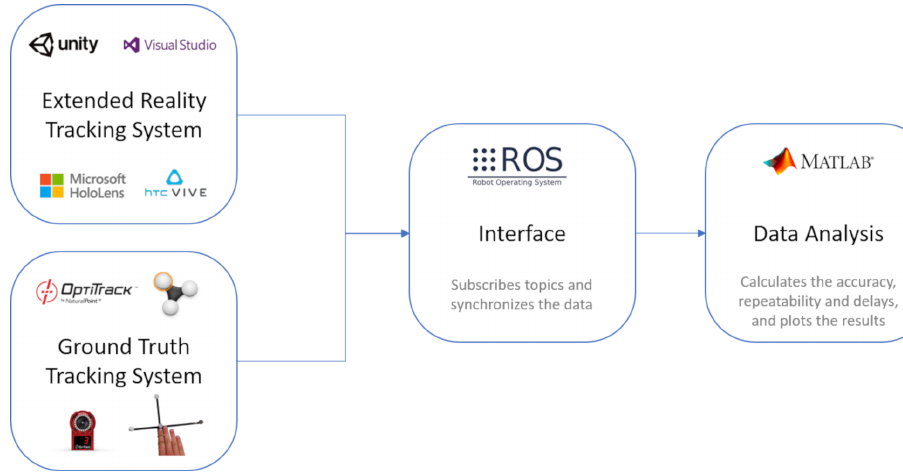
Figure 1. Overview of the system developed for the